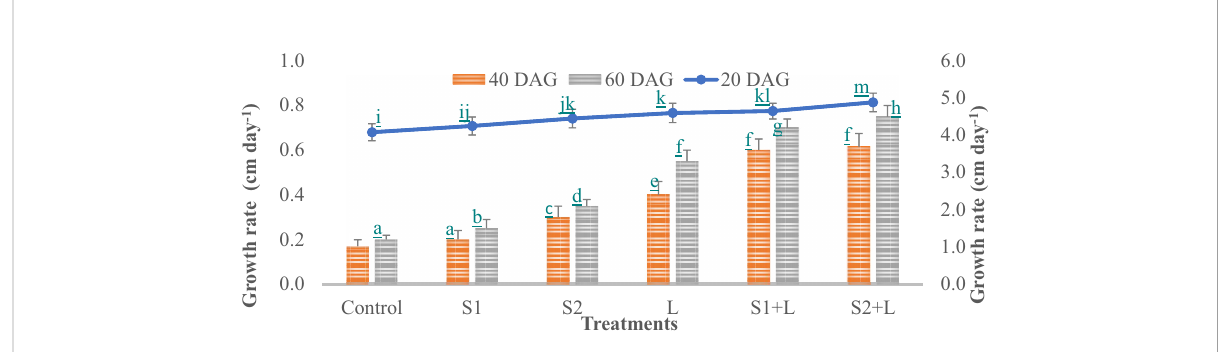
FIGURE 2 In fl uence of Rhizobium strains inoculation on growth rate of French bean. T-shaped bar at the top of each bar indicates standard error (SE), and different letters on top indicate statistical difference (Duncan ’ s multiple-test range), p =